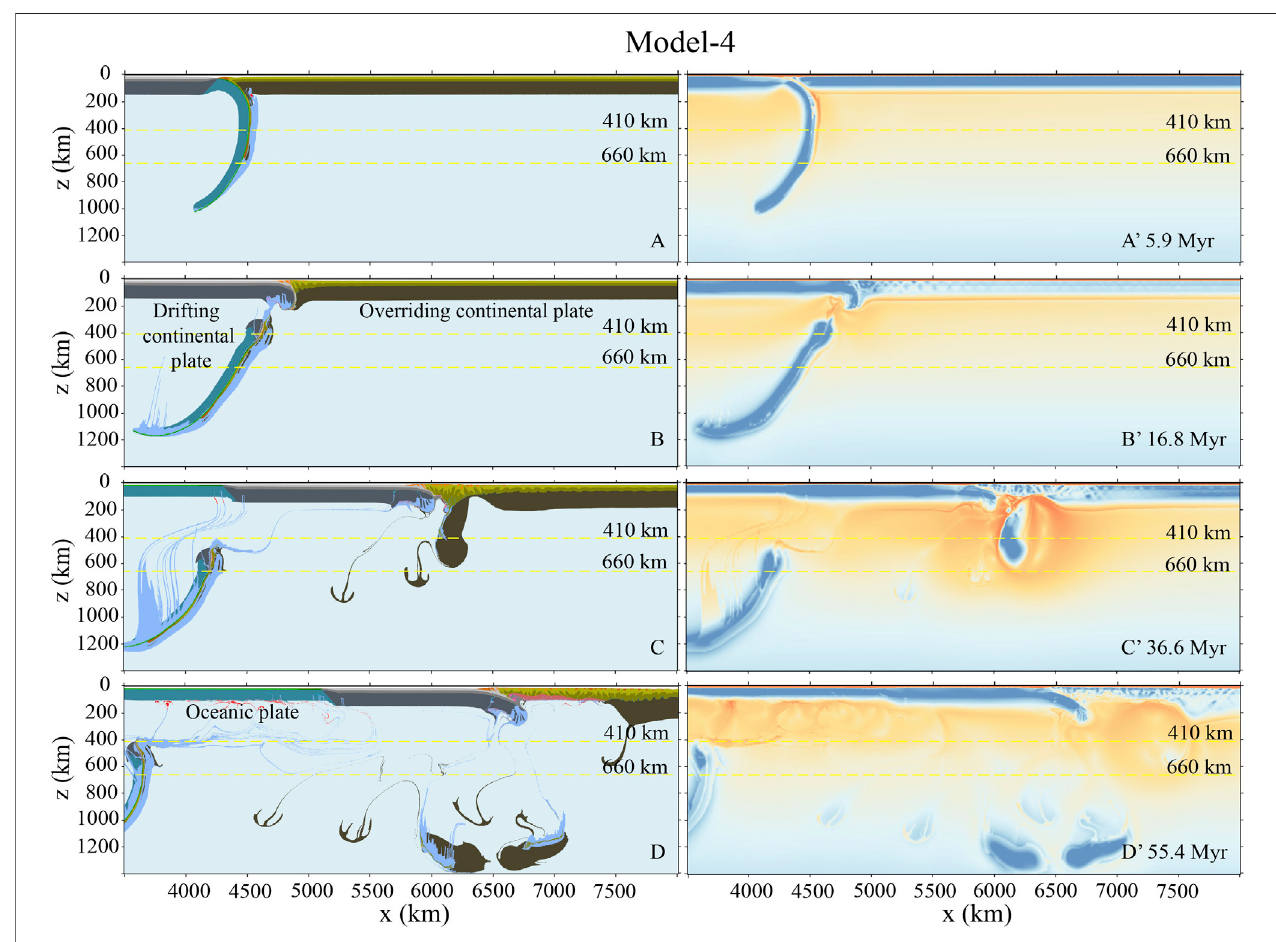
FIGURE 6 | Model-4 evolution with a further decreased and uniform plastic friction coef fi cient of the overriding lithospheric mantle of λ · sin ( φ ) (cid:2) 0.01 ( Supplementary Table S2 and Supplementary Equation S11 in the supporting information). All the other parameters are identical to Model-3 ( Figure 5 ). (A – D) The composition fi eld evolution with the corresponding colorbar is shown in Figure 2A . (A ’ – D ’ ) The effective viscosity evolution with the corresponding colorbar is shown in Figure 2B .